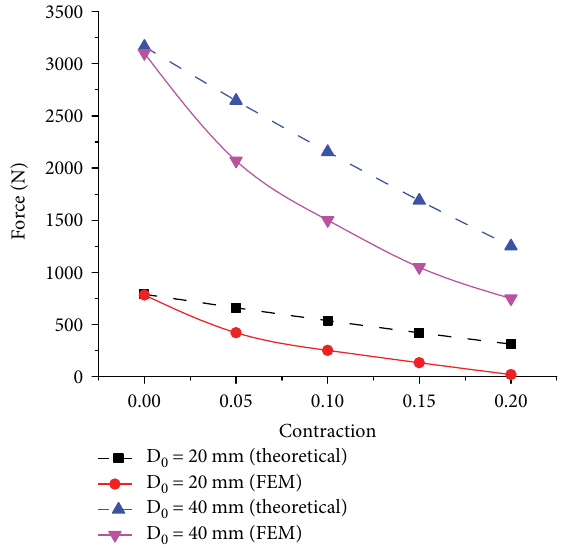
Figure 8: Static contraction-pressure profile under the loads of 100 N, 200 N, and 300 N (isotonic